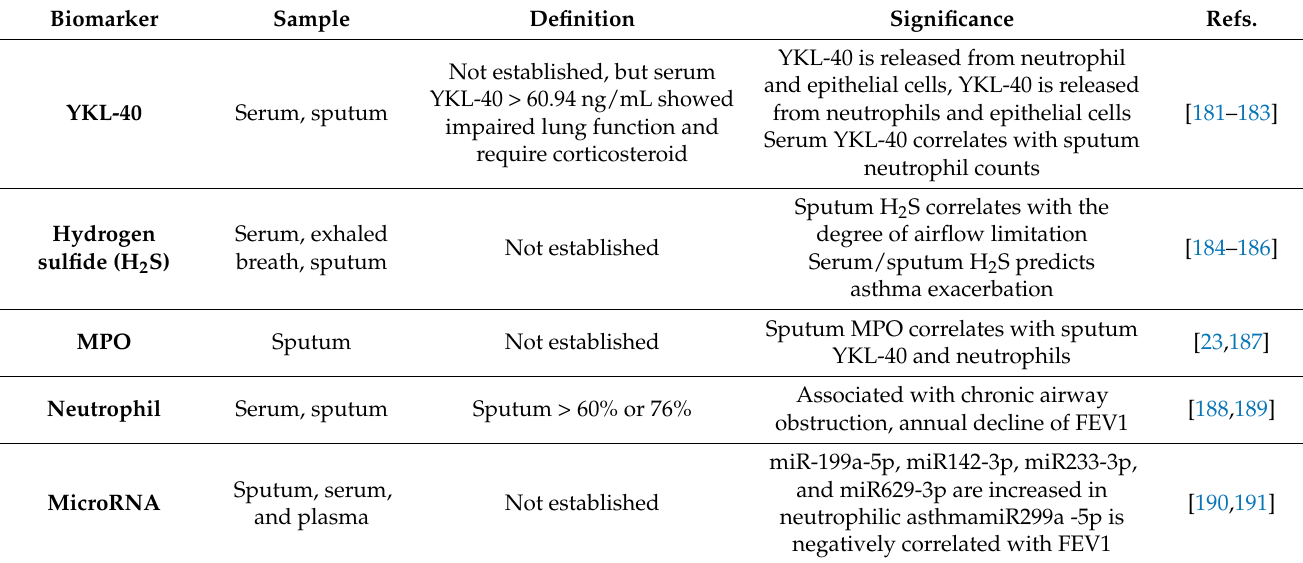
Table 1. Possible biomarkers for neutrophilic